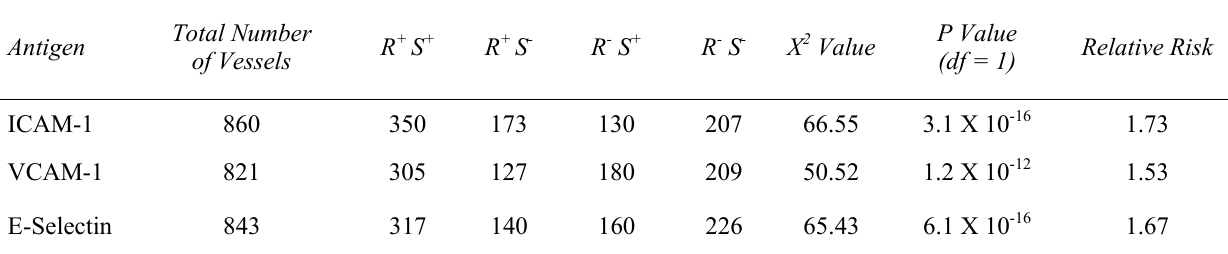
Table 2: Quantitation of Cerebral Vessels and Co-localization of Sequestration with Expression of Receptors in the 15 Malaria Cases.